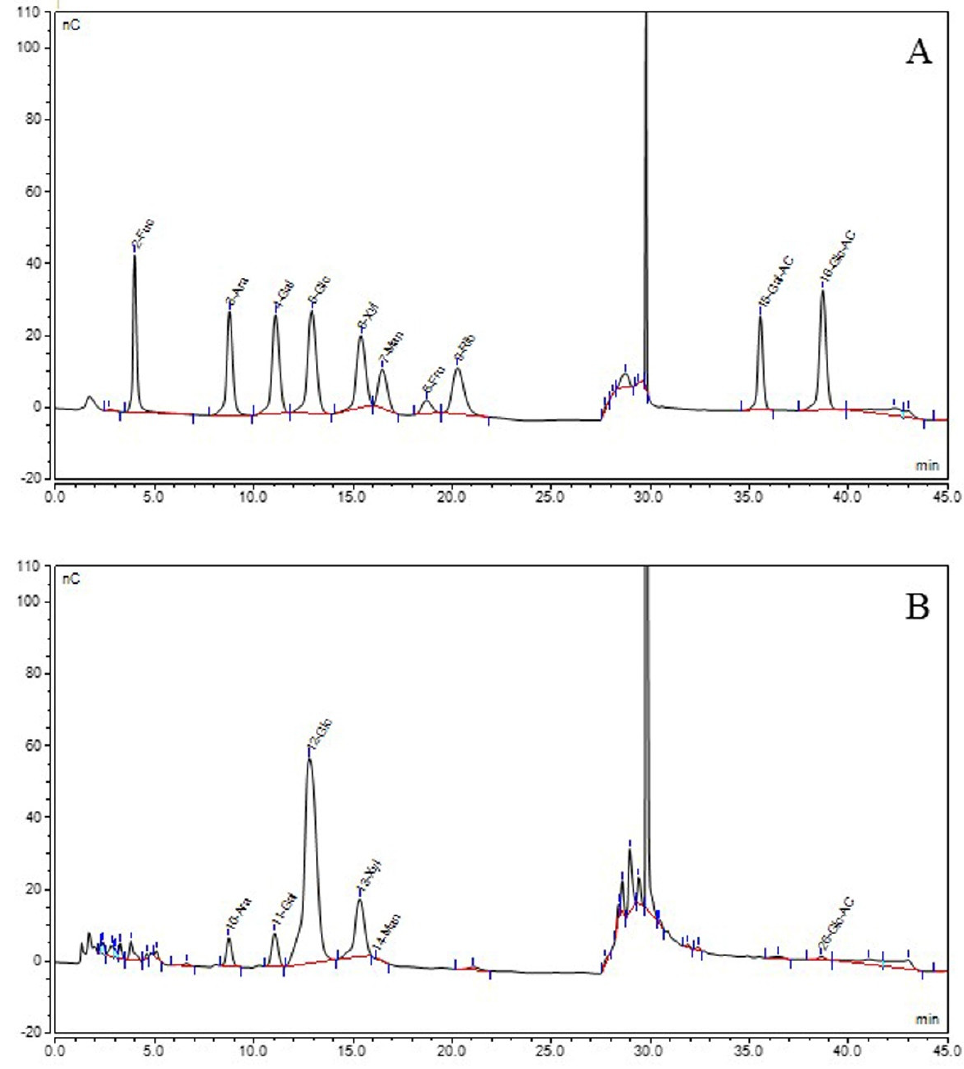
Figure 1. Chromatogram of standard monosaccharide ( A ) and component monosaccharides released from BSPs ( B ).